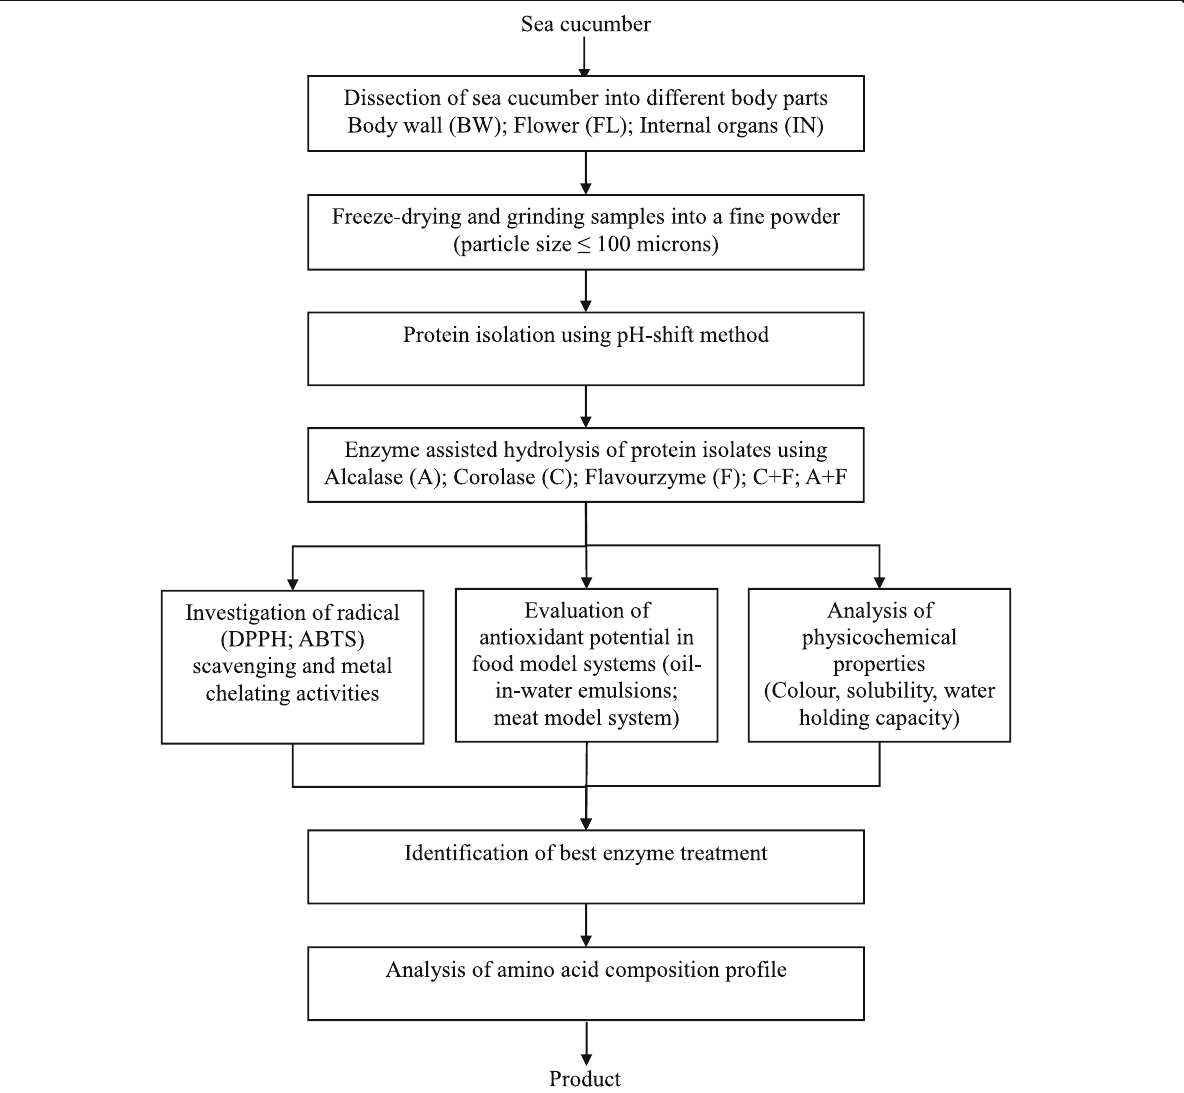
Fig. 2 Experimental plan of evaluating antioxidant potential and physicochemical properties of sea cucumber protein hydrolysates